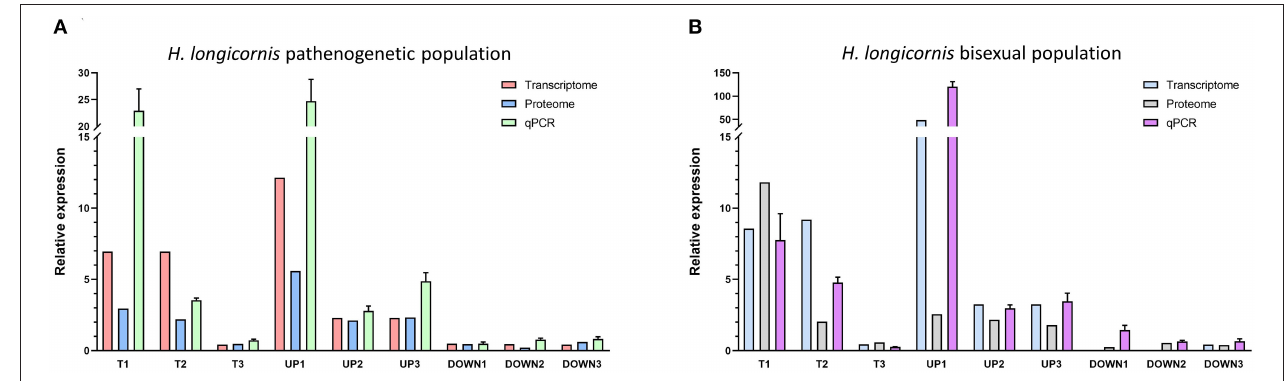
FIGURE 5 | Quantitative PCR of differentially expressed genes and proteins in the different feeding stages of bisexual and parthenogenetic groups. Data from 17 of the 18 groups followed the same expression trend as the transcriptome and proteome data. (A) Quantitative analysis of bisexual H. longicornis (HLBP) for Differentially expressed proteins (DEPs). (B) Quantitative analysis of parthenogenetic H. longicornis (HLBP) for Differentially expressed proteins